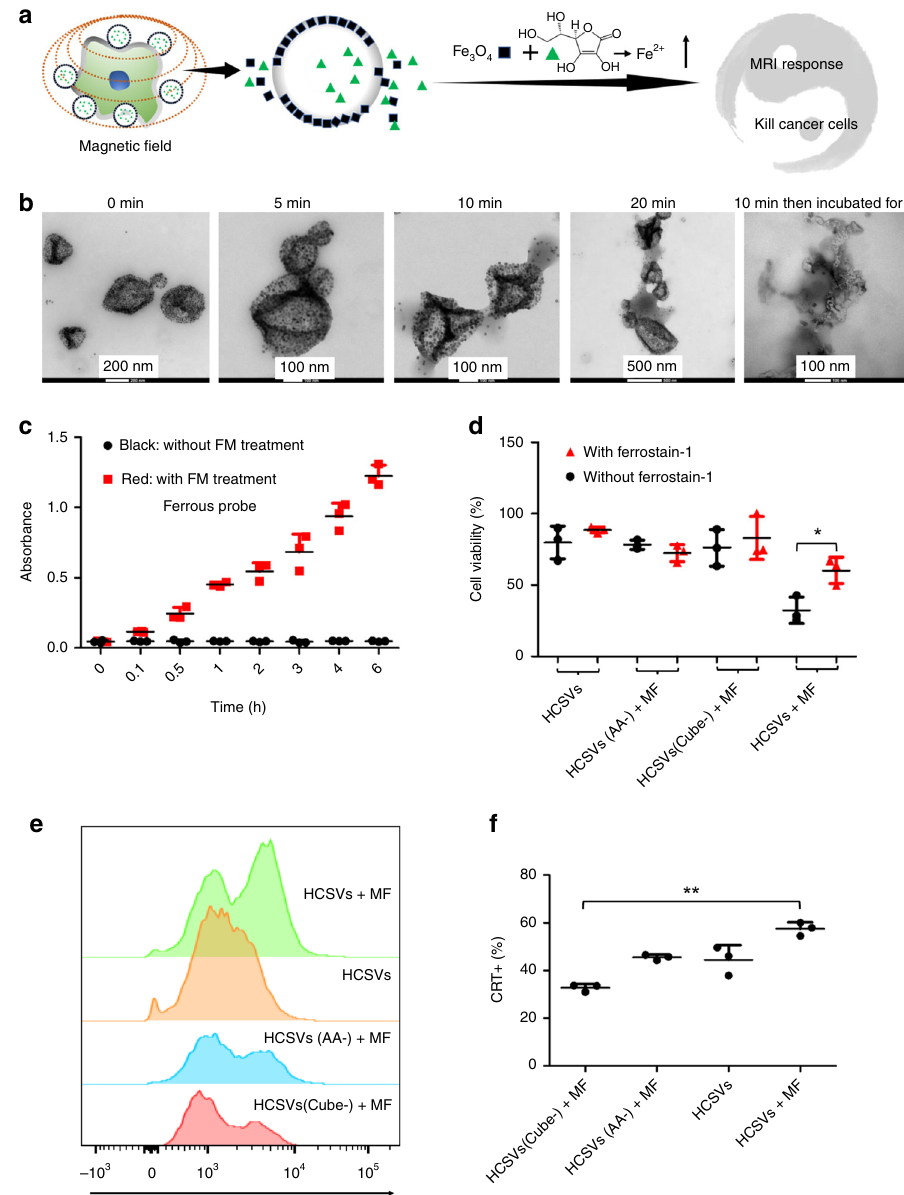
Fig. 1 Exogenous MF-boosted Ferroptosis-like cell death. a Scheme of exogenous MF-boosted Fenton reaction and responsive magnetic resonance imaging (MRI) using HCSVs, b TEM images of HCSVs treated with the circularly polarized magnetic fi eld (MF, 2 Hz) for various time-periods. Experiments were repeated three times. c Relative concentration change of Ferrous ions tested by the ferrous probe, n = 3 independent samples. Data are shown as means ± s.d. d Ferrostatin-1 rescued TRAMP-C1 cells treated with HCSVs with/without MF, n = 3 independent samples. P = 0.017 e Flow cytometry assay of calreticulin (CRT) exposure on the surface of TRAMP-C1 after various treatment. f Relative quanti fi cation of Flow cytometry assay of CRT exposure. n = 3 independent samples. Data are shown as means ± s.d. p < 0.05, two-tailed paired t -test. Source data are provided as a Source data fi